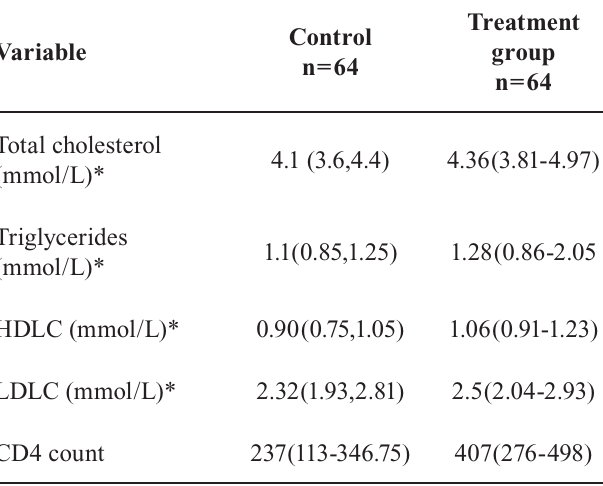
TABLE II - Baseline lipid values in control and treatment group